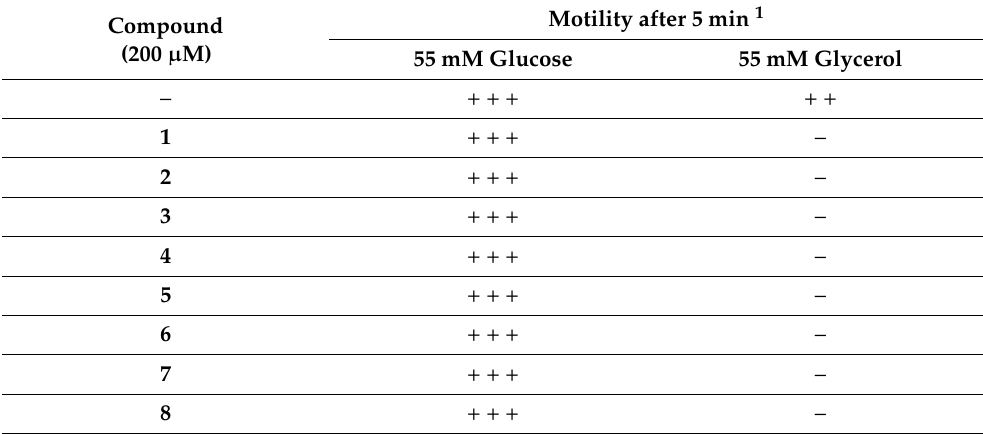
Table 6. Effect of gallic acid alkyl esters on the motility of proliferating T. brucei bloodstream forms in the presence of glucose or